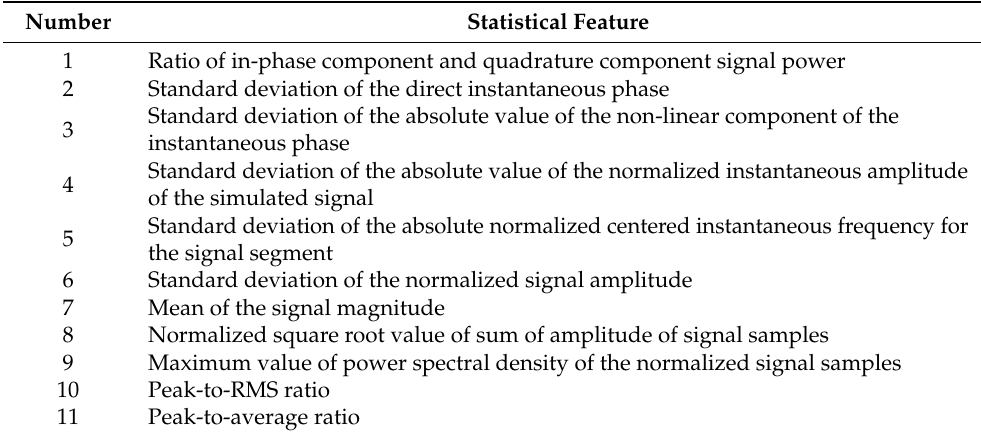
Figure 5. Convolutional neural network for automatic modulation classification. ( a ) Functional structure for received signal classification; ( b ) convolutional neural network (CNN) layer structure. Table 1. Statistical features for automatic modulation classification.